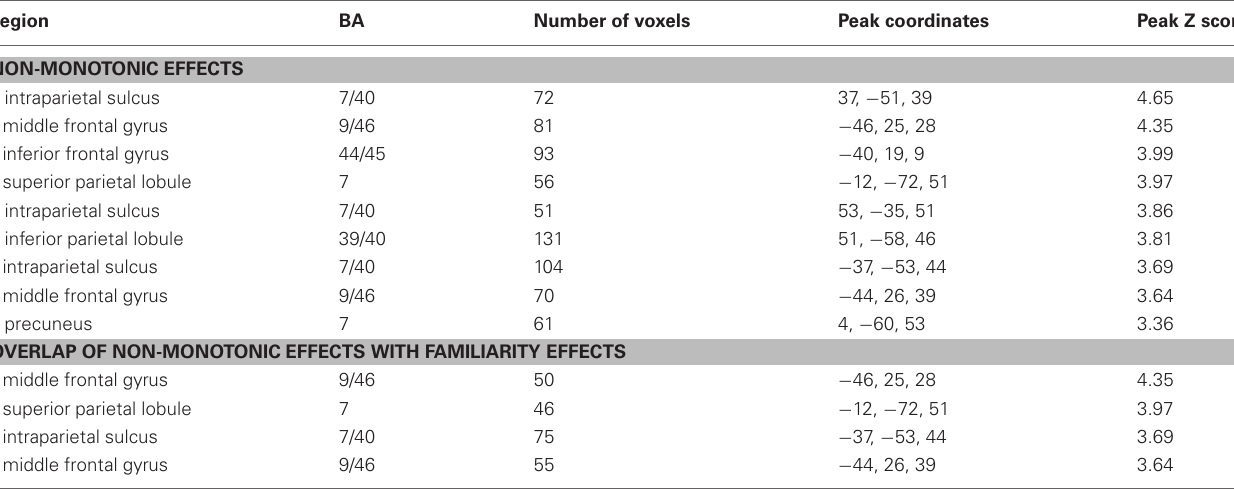
Table 4 | Regions exhibiting non-monotonic effects across test-phase judgments.